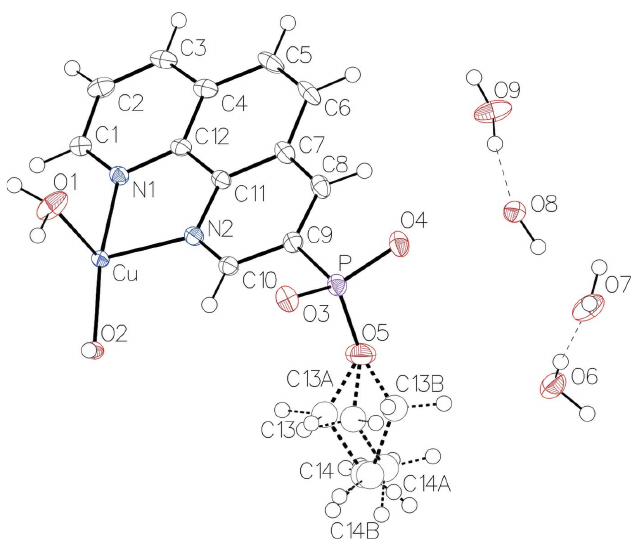
Figure 1 ORTEP view of the asymmetric unit of the title compound. Displacement ellipsoids are drawn at the 50% probability